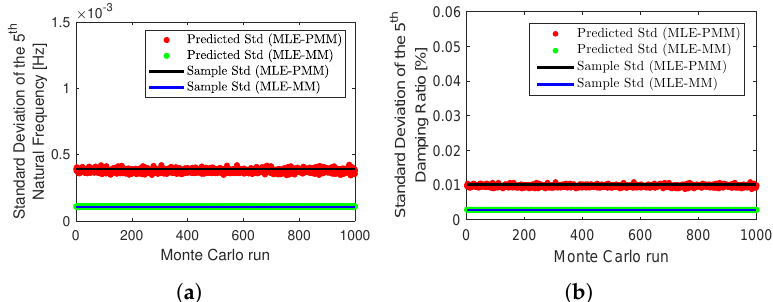
Figure 19. Monte Carlo simulation results for the lattice tower example with 5% of noise level: sample standard deviation of the natural frequencies ( a ) and damping ratios ( b ) (solid line) estimated for the 5th mode and the corresponding standard deviations predicted from a typical Monte Carlo dataset after 20 iterations of MLE-PMM (dots).